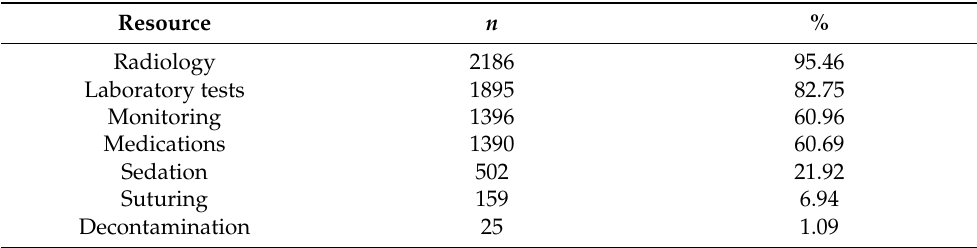
Table 3. Resource requirements for patients under the influence of alcohol in the emergency depart- ment.